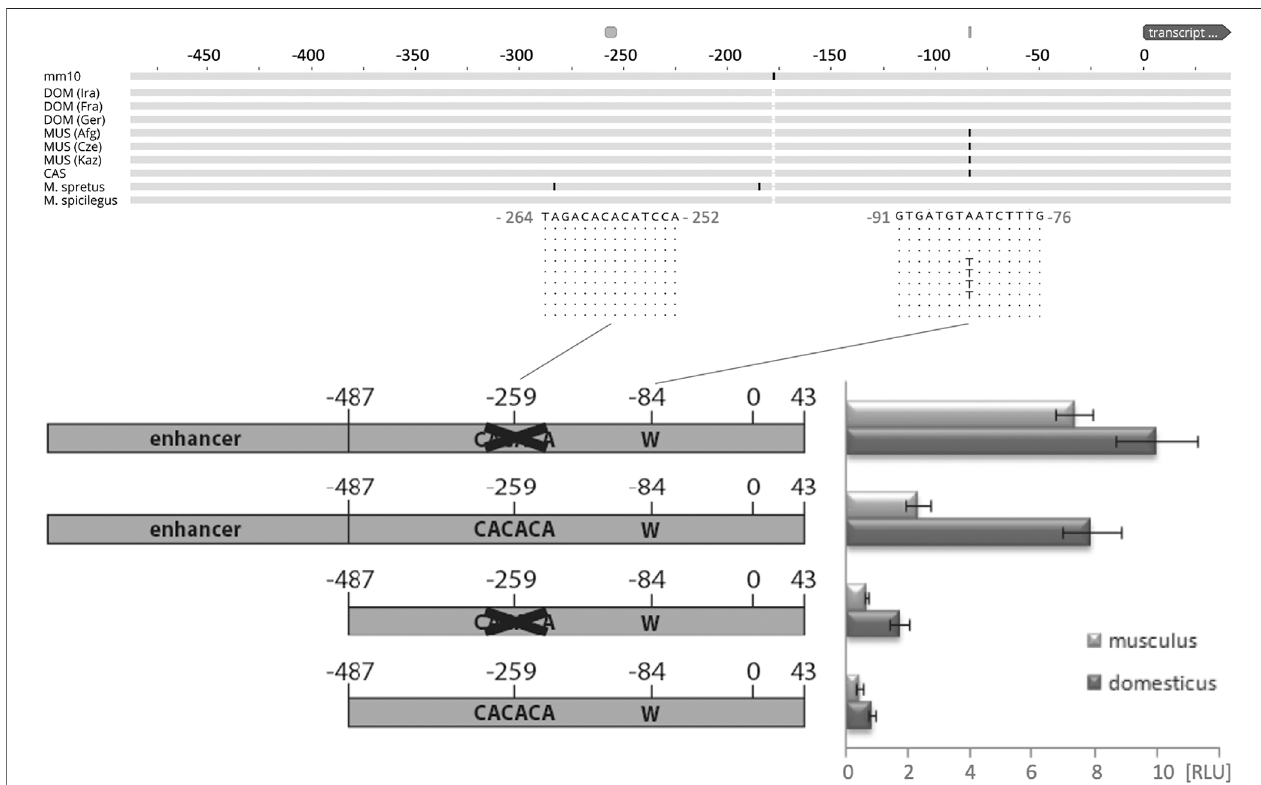
FIGURE 4 | Functional test of the promoter region driving the new transcript. The top shows the alignment scheme of genomic sequences from populations, sub- species, and species based on the genome data described in (Harr et al., 2016), aligned to the mouse GRCm38/mm10 reference sequence. The fragment shown represents the one used for the promoter studies - only replacements with respect to the reference are marked, the two relevant regions discussed in the text are enlarged with their respective sequences. DOM represents M. m. domesticus populations, MUS represents M. m. musculus populations, CAS representsa M.m. castaneus population. T/A is the only mutation that correlates with the expression of the new promoter. Note that the transcriptional start site, marked as “ 0 ” , is located between the annotated site for this transcript, which would be 31 bp further upstream, and the site from which the bulk of the transcripts generated in the RNASeq experimentstarts,whichis8 bpdownstream(see SupplementaryFigureS2 foracorrespondingsequencedepictionofthisregion).Thebottomshowstheschemeof thefourconstructstestedincellcultureandtheirexpressionlevelsmeasuredasrelativeluminescenceunits[RLU](seeMethods).Errorbarsindicatestandarddeviations from eight replicates; all differences are signi fi cant ( p < 0.05, t